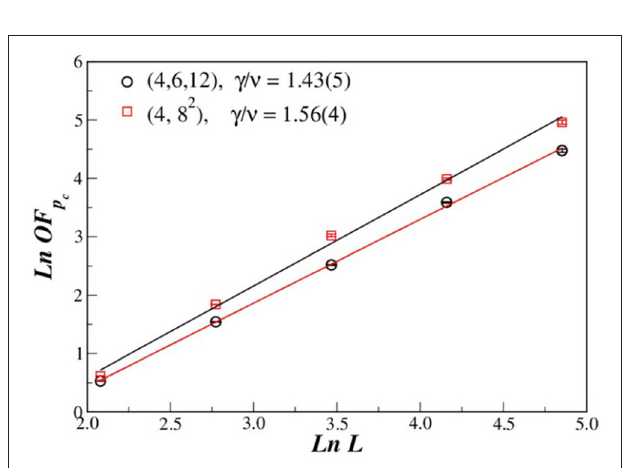
FIGURE 6 | Plot of ln | p c ( L ) − p c | vs. the linear system size L for (4,6,12) and (4,8 2 ) AL. Fitting data, we obtained the estimation for the critical exponent 1 /ν